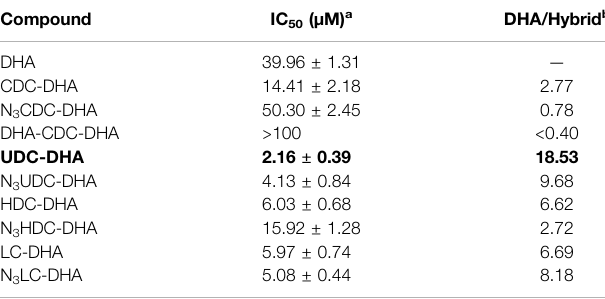
TABLE 1 | IC 50 values of DHA and BA-DHA hybrids in Huh-7 cells (72 h treatment).